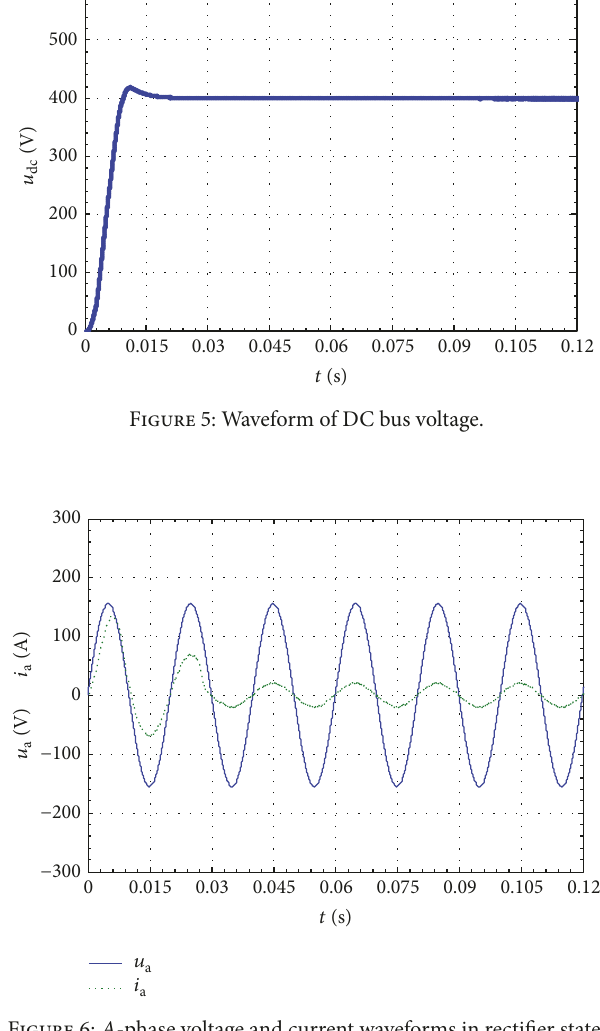
Figure 6: 𝐴 -phase voltage and current waveforms in rectifier state.